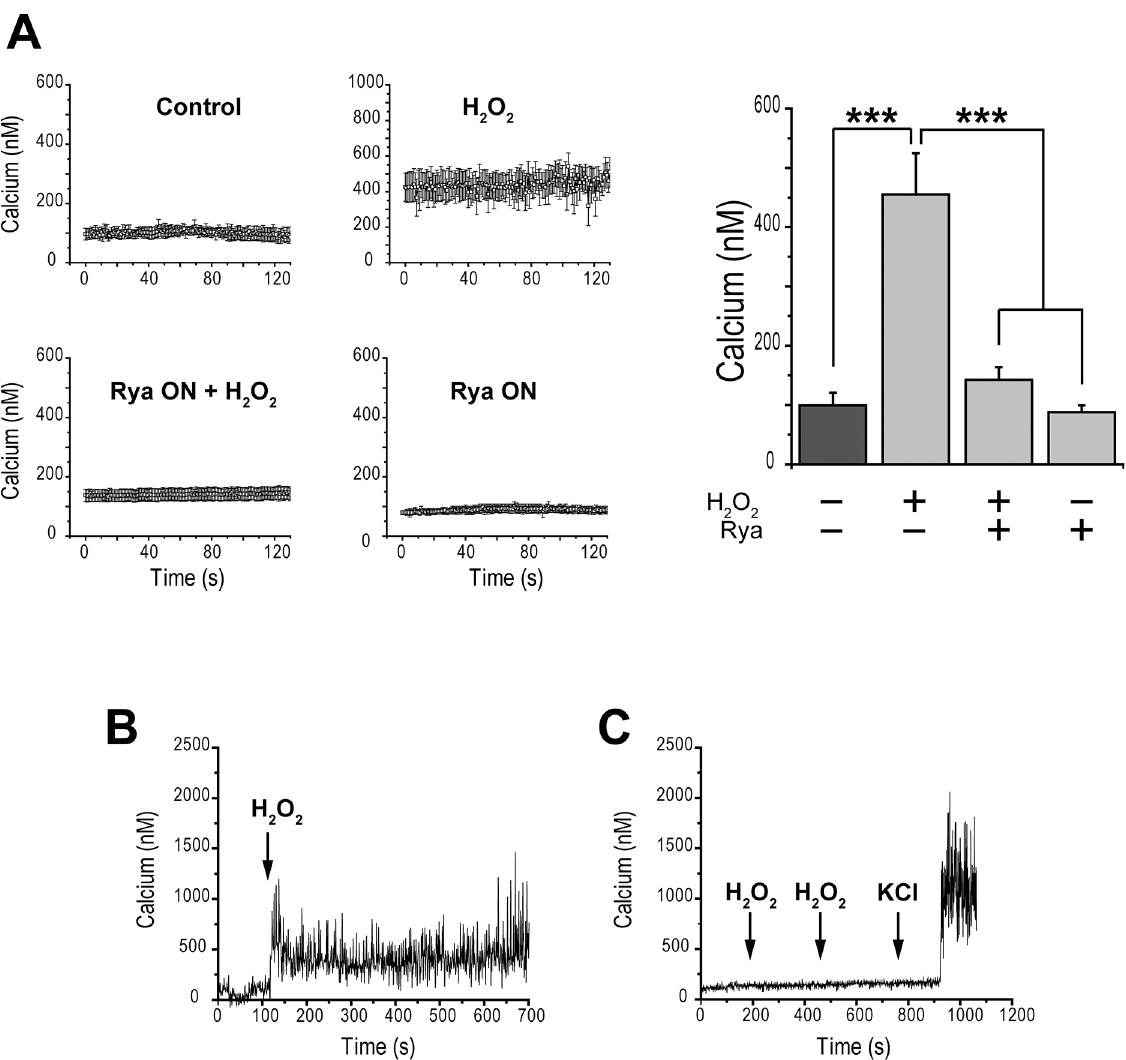
Fig 7. Incubation with exogenous H 2 O 2 increases [Ca 2+ ] i in pancreatic β -cells via activation of RyR-mediated Ca 2+ release. (A) Records of [Ca 2+ ] i vs time obtained from rat pancreatic β -cells pre-incubated for 1 h with 2 μ M fura-2-AM in Hanks basal solution (2.8 mM glucose). Control: cells were kept in basal Hanks solution. H 2 O 2 : cells were pre-incubated for 1 h with 100 μ M H 2 O 2 in basal Hanks solution. H 2 O 2 + Rya ON: cells were pre-incubated with 200 μ M ryanodine (Rya) for 12 h and were then incubated for 1 h with 100 μ M H 2 O 2 (in ryanodine-free solution) prior to recording in basal Hanks solution (H 2 O 2 free). Rya ON: cells were pre-incubated with 200 μ M ryanodine for 12 h. At right, quantification of these results, given as Mean ± SEM, N = 3 – 7. Statistical significance was determined with one-way ANOVA followed by Tukey multiple comparison test. *** : p < 0.001. (B) Average record (N = 3) of Ca